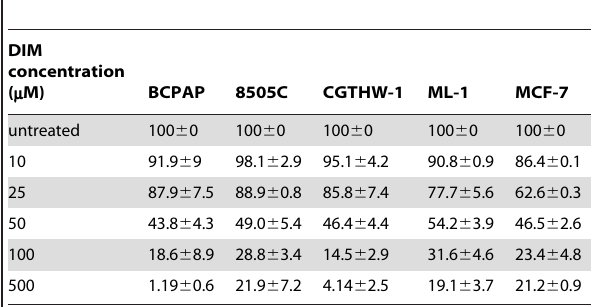
Table 1. Thyroid cell survival assay.